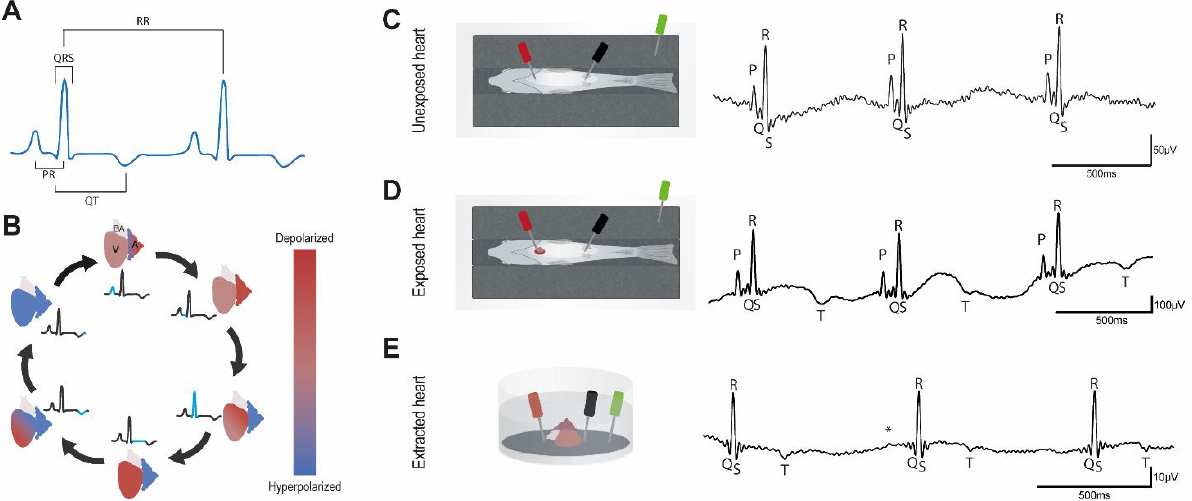
Figure 1. ECG representation and typical recordings; ( A ), Schematic representation of the interval measurement method. We chose to take the peak of the P and T waves to determine PR and QT intervals respectively to reduce the uncertainty of the measurements when taking before P waves or after T waves; ( B ), Cartoon representing the different depolarization and repolarization steps of the zebrafish heart cavities. A: atrium, V: ventricle, BA: bulbus arteriosus; ( C – E ), Schematic representation of the electrode positioning in the different configurations and representative traces; ( C ), Unexposed heart; ( D ), Exposed heart; ( E ), Extracted heart, * indicates putative P wave. Traces show three consecutive ECG complexes after application of a 50 Hz low-pass filter.